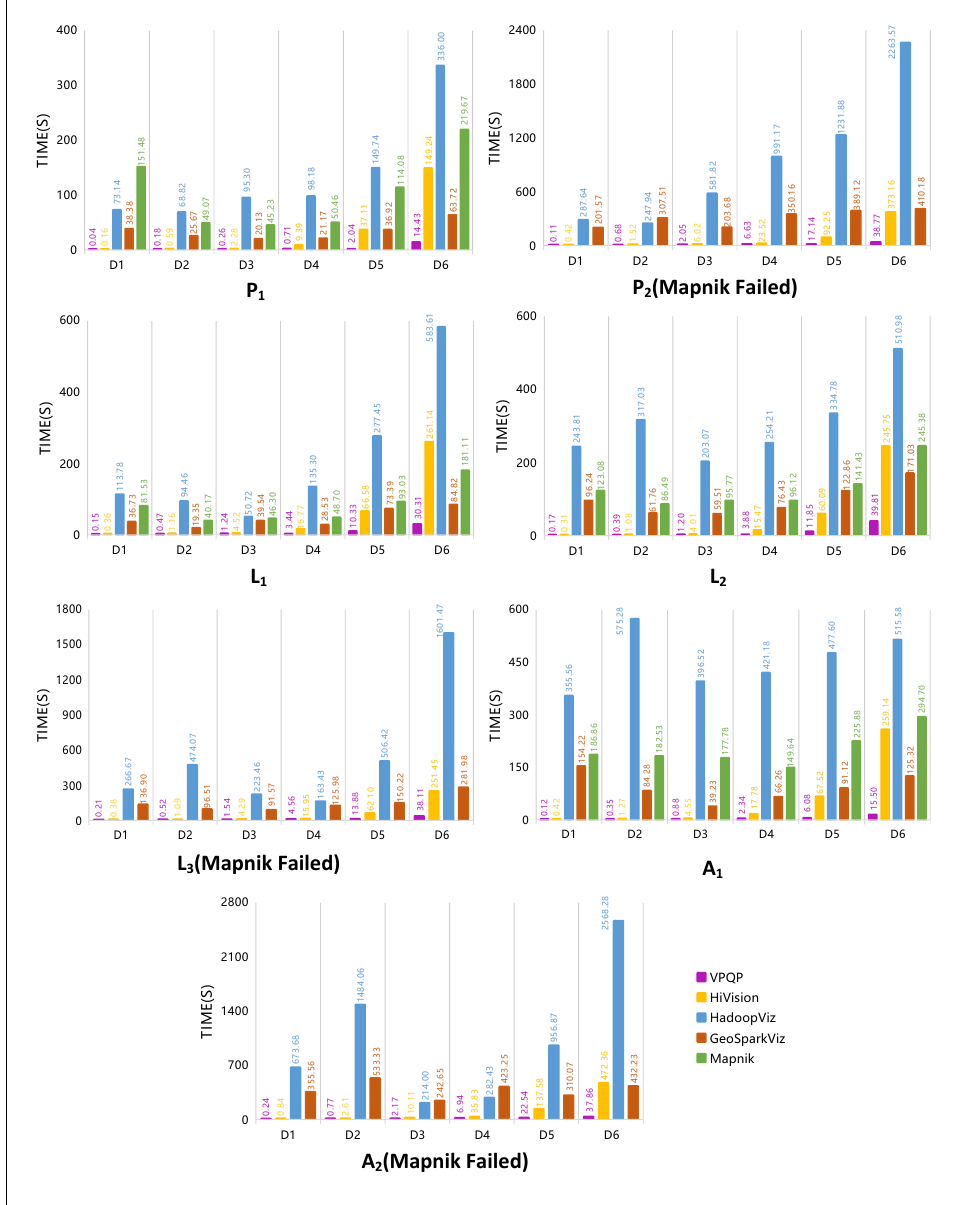
Figure 3. Comparative results of the rendering performance of different